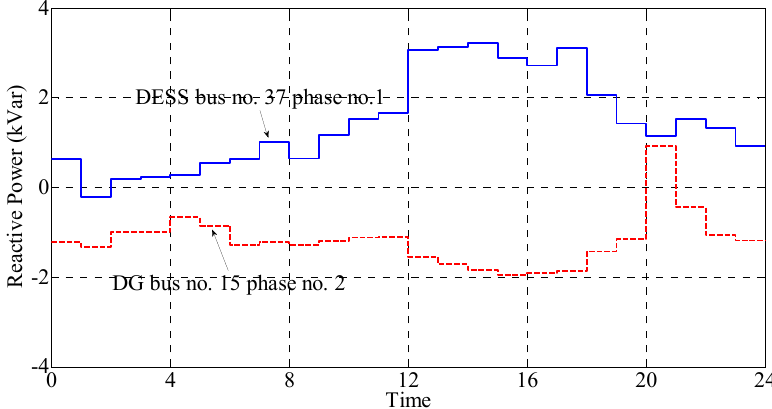
Figure 14. Case Study 3: Energy stored by the DESS at bus no.37 during the last typical day.